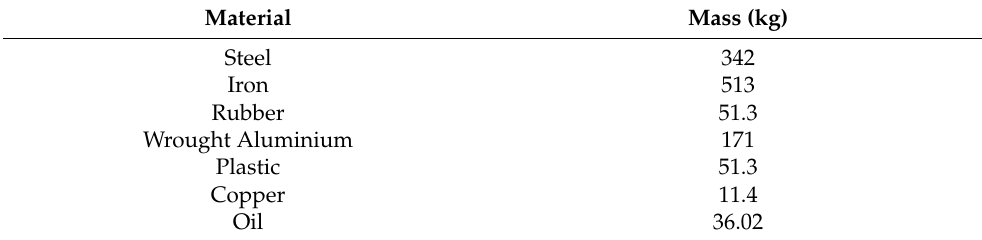
Table 4. BOM for ICE [25].